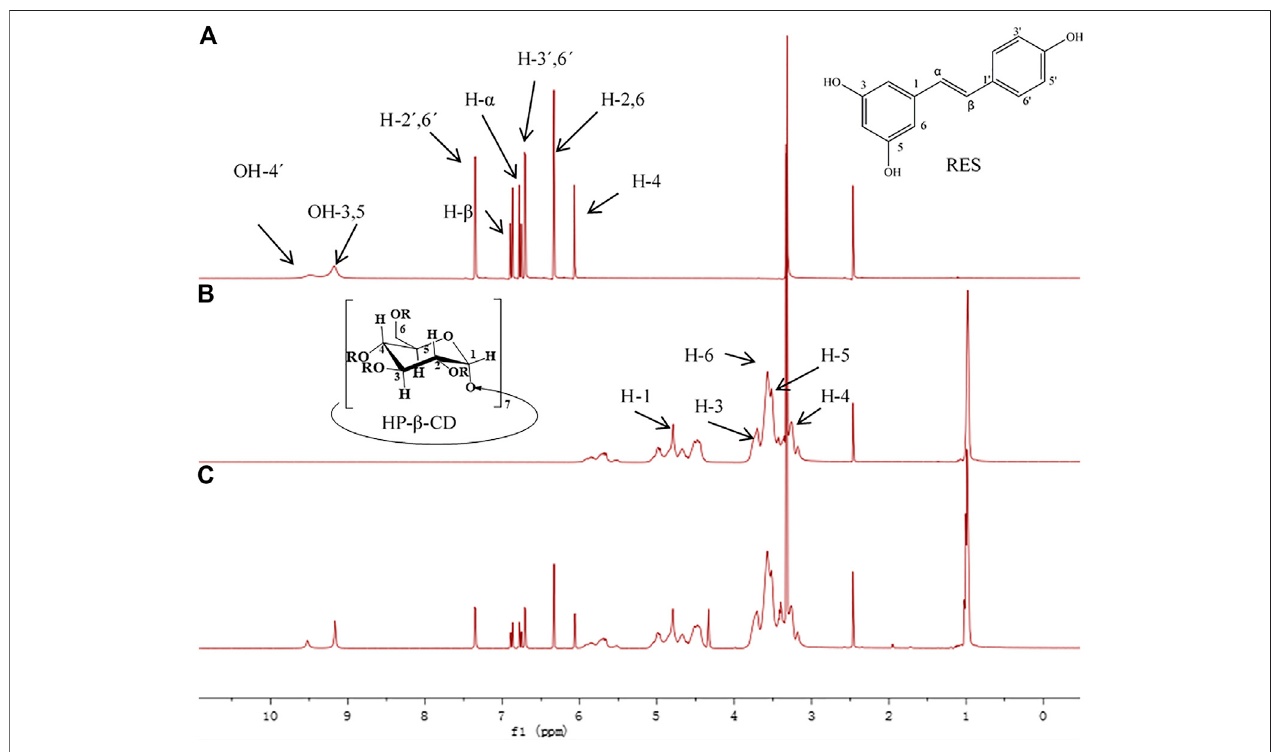
FIGURE 4 | The 1 H NMR spectra of resveratrol (A) , HP- β -CD (B) and the RHSD inclusion complex (C) .